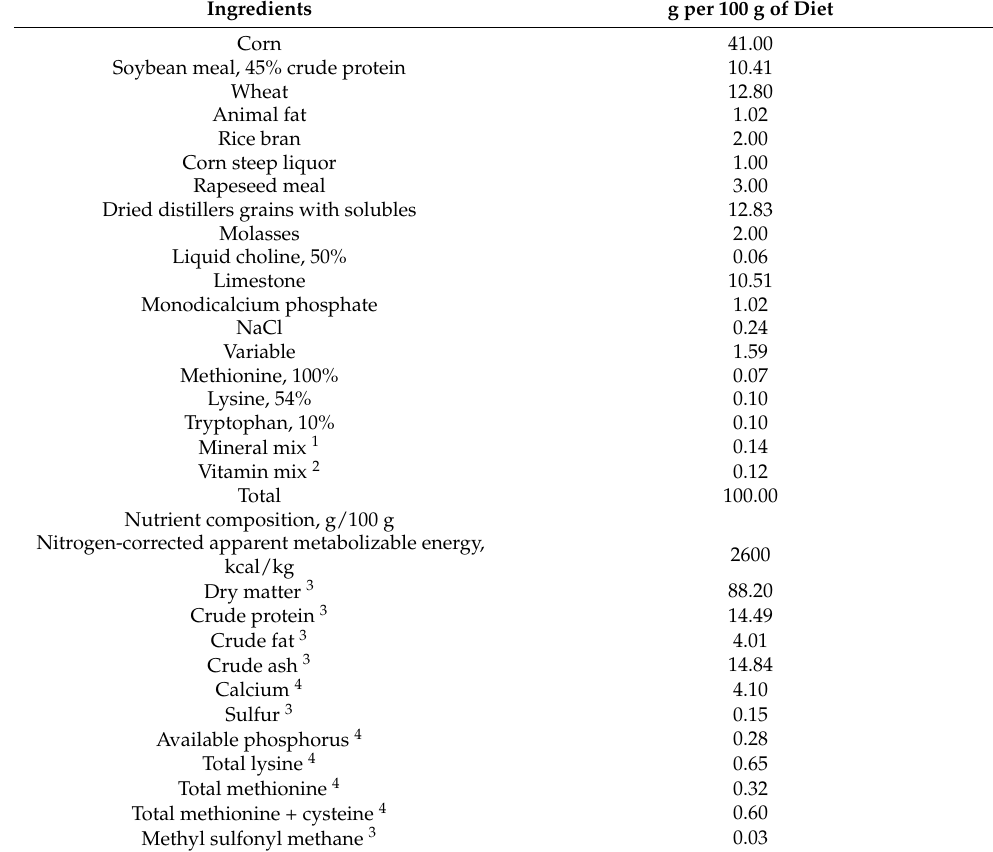
Table 1. Ingredient and nutrient composition of the basal diet.